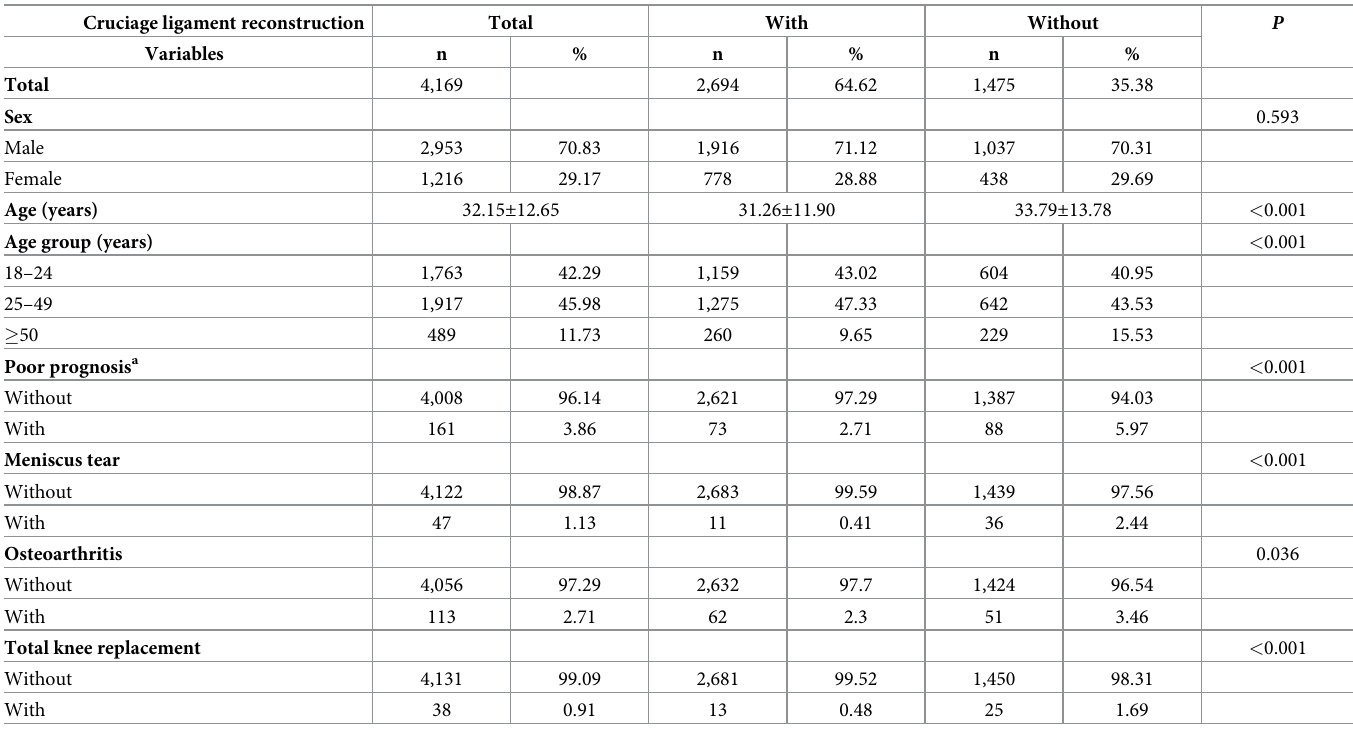
Table 2. Characteristics of PCL-injured patients with and without reconstruction. Cruciage ligament